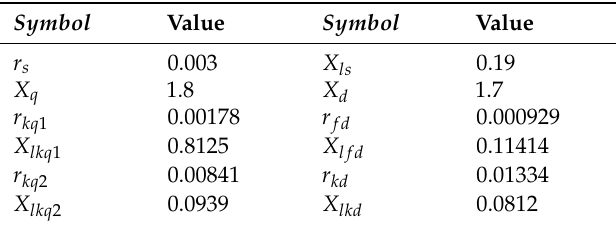
Table A1. Parameters of the synchronous generator [9].